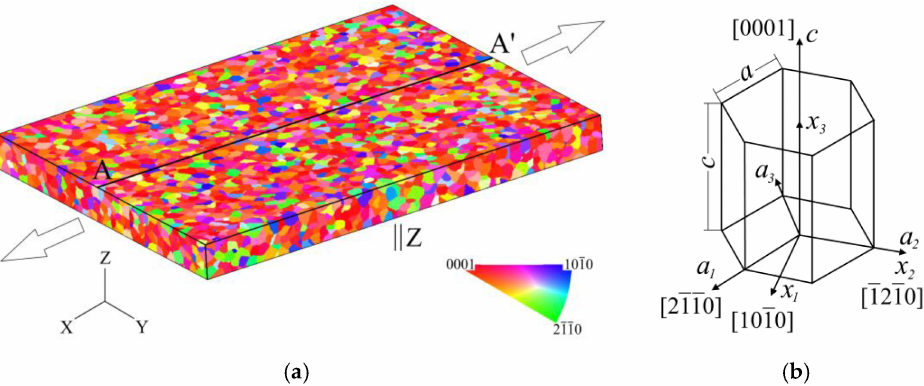
Figure 2. Model microstructure consisting of 12,000 grains shown in the IPF colors for the Z direction ( a ) and the crystalline and orthonormal coordinate frames of a hexagonal lattice ( b